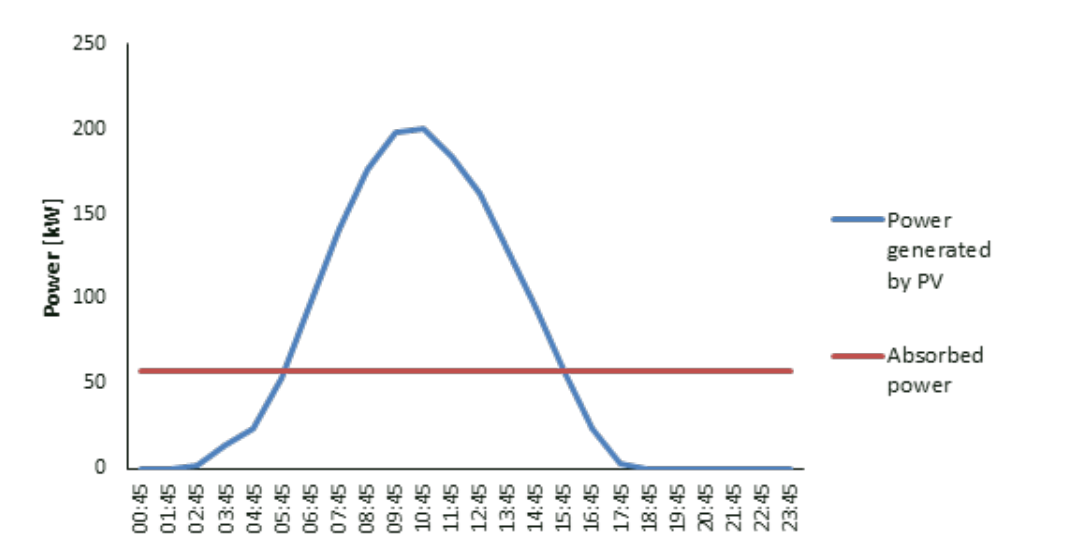
Figure 6. Hourly average power of WWTP for a typical day in July.